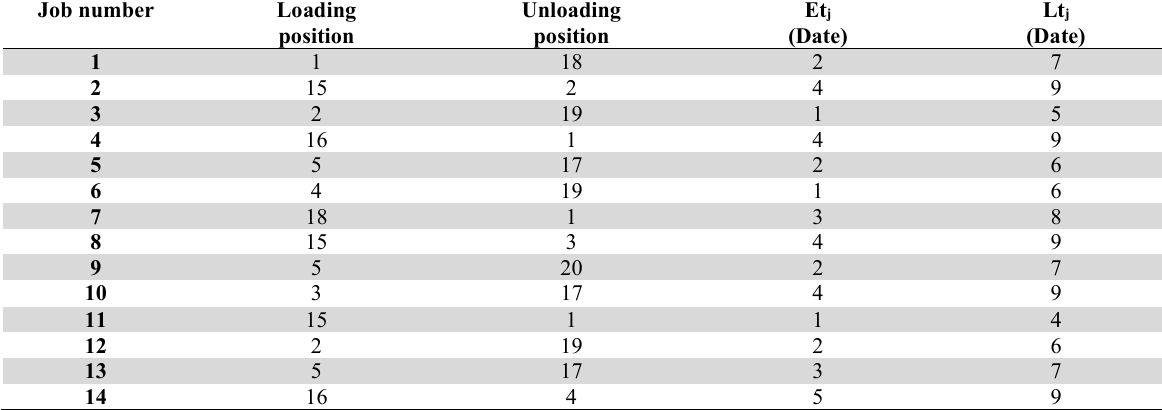
Job description